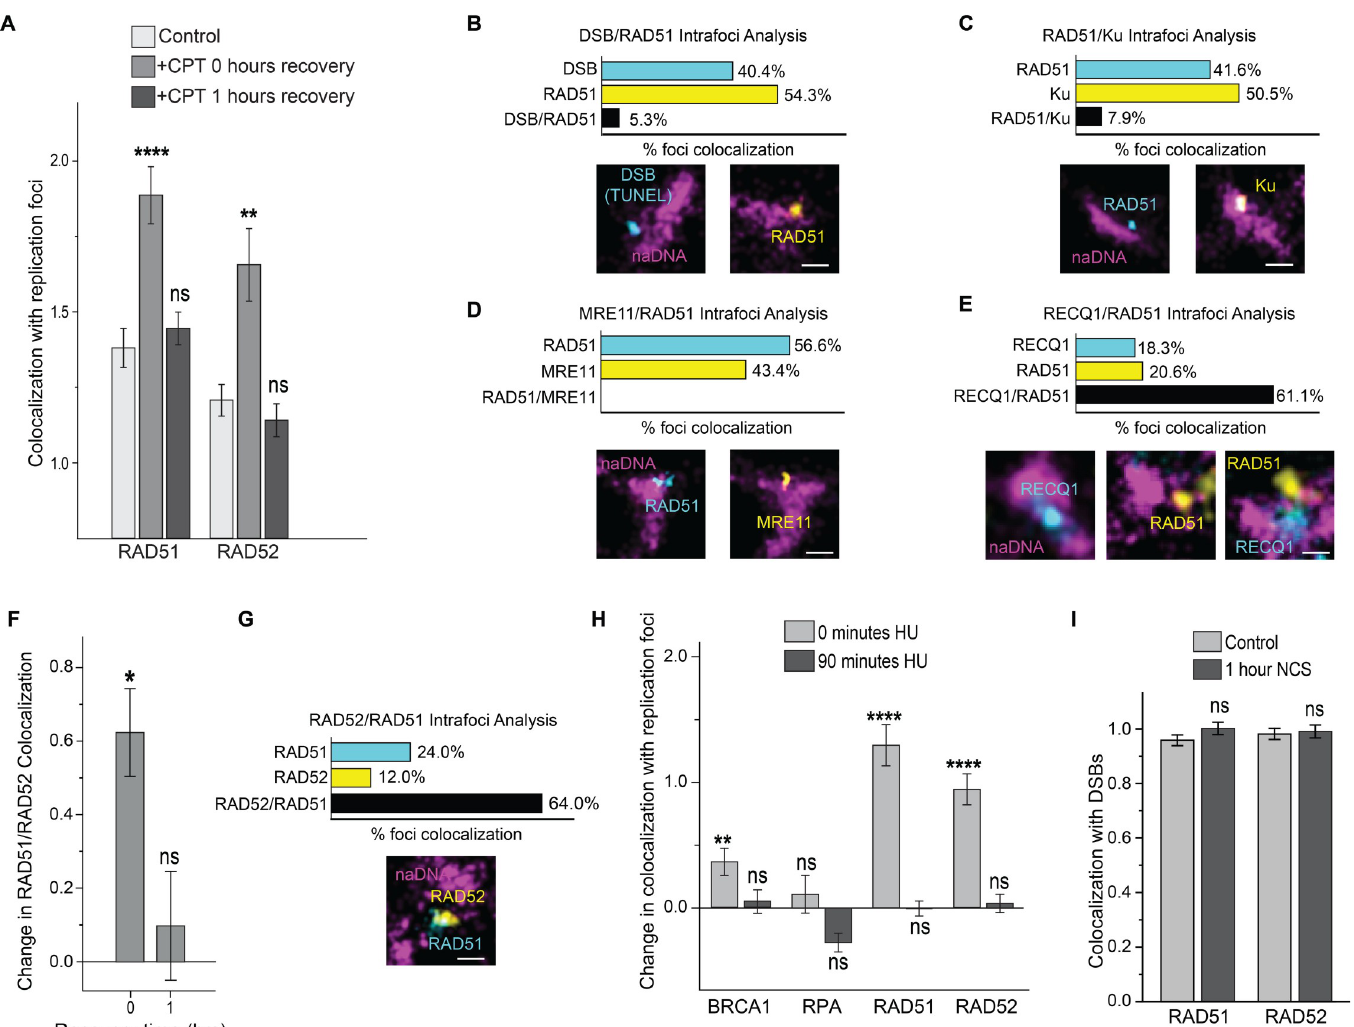
Fig 4. RAD51 and RAD52 are first responders to stalled/regressed RFs. (A) Quantification of RAD51 and RAD52 colocalization with RF foci immediately after CPT damage and following 1 hour of recovery. Representative whole-cell control and CPT-treated cells shown in S10A and S10B Fig. (B) Three color analysis of RAD51 and DSB (TUNEL) localization at RF foci immediately following 1 hour of CPT damage. Representative whole-cell control and CPT-treated cells shown in S10C and S10D Fig. (C) Three color analysis of RAD51 and Ku localization at RF foci immediately following 1 hour of CPT damage. Representative whole-cell control and CPT-treated cells shown in S10E and S10F Fig. (D) Three color analysis of RAD51 and MRE11 localization at RF foci immediately following 1 hour of CPT damage. Representative whole- cell control and CPT-treated cells shown in S10G and S10H Fig. (E) Three color analysis of RAD51 and RECQ1 localization at RF foci immediately following 1 hour of CPT damage. Representative whole-cell control and CPT-treated cells shown in S10I and S10J Fig. (F) Quantification of colocalization of RAD51/RAD52 immediately following 1 hour of CPT treatment and after 1 hour of recovery in normal medium, normalized to control levels. (G) Three color analysis of RAD52 and RAD51 localization at RF foci immediately following 1 hour of CPT damage. Representative whole-cell control and CPT-treated cells shown in S10A and S10B Fig. (H) Quantification of protein colocalization with naDNA RF foci at unbroken HU-stressed RFs immediately following 4 hours of HU treatment and after 90 minutes of recovery in normal medium from HU treatment, normalized to control levels. (I) Quantification of RAD51 and RAD52 colocalization with DSBs (TUNEL signal) in control and NCS-damaged cells. Representative foci shown, scale bars represent 250 nm. Complete N values available in S1 and S2 Tables, number of replicates > 3, number of cells imaged typically 20–60, number of individual foci manually scored typically 50–70. All graphs show mean ± s.e.m. Student’s t-test results shown for comparison with control levels: ns depicts p > 0.05, � depicts p < 0.05, �� depicts p < 0.01, ���� depicts p <